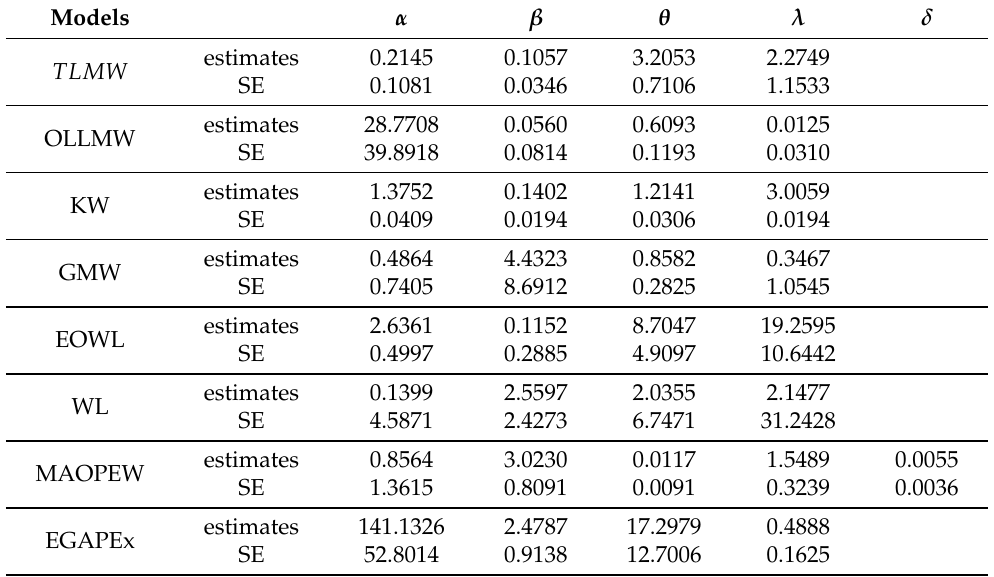
Table 19. MLE for parameters of TLMW and comparative models for single carbon fibers data.